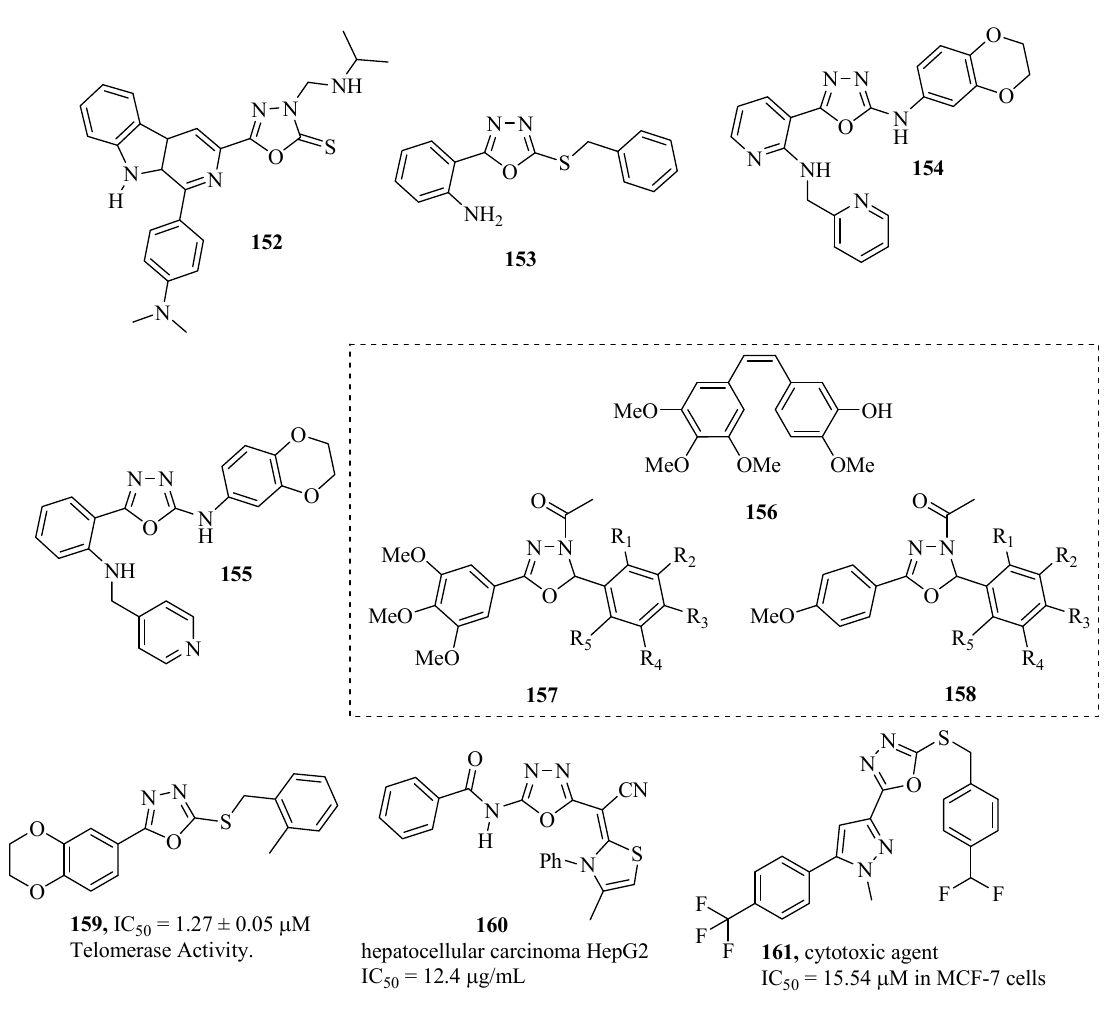
Figure 10. 1,3,4-Oxadiazoles with antitumor